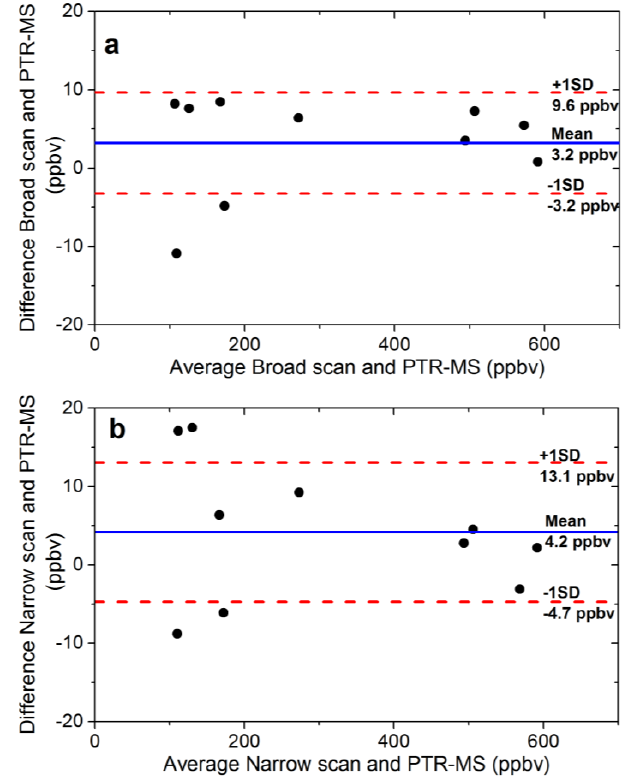
Figure 5. Bland-Altman plot of breath acetone from ten persons measured with the EC-QCL-based system and compared to proton-transfer reaction mass spectrometer (PTR-MS). ( a ) broadband scan mode and ( b ) narrowband scan mode. Solid line represents the mean difference between the two systems. Dashed lines represent the limits of agreement: (a) −3.2 ppbv and 9.6 ppbv and (b) −4.7 ppbv and 13.1 ppbv; SD is standard deviation.